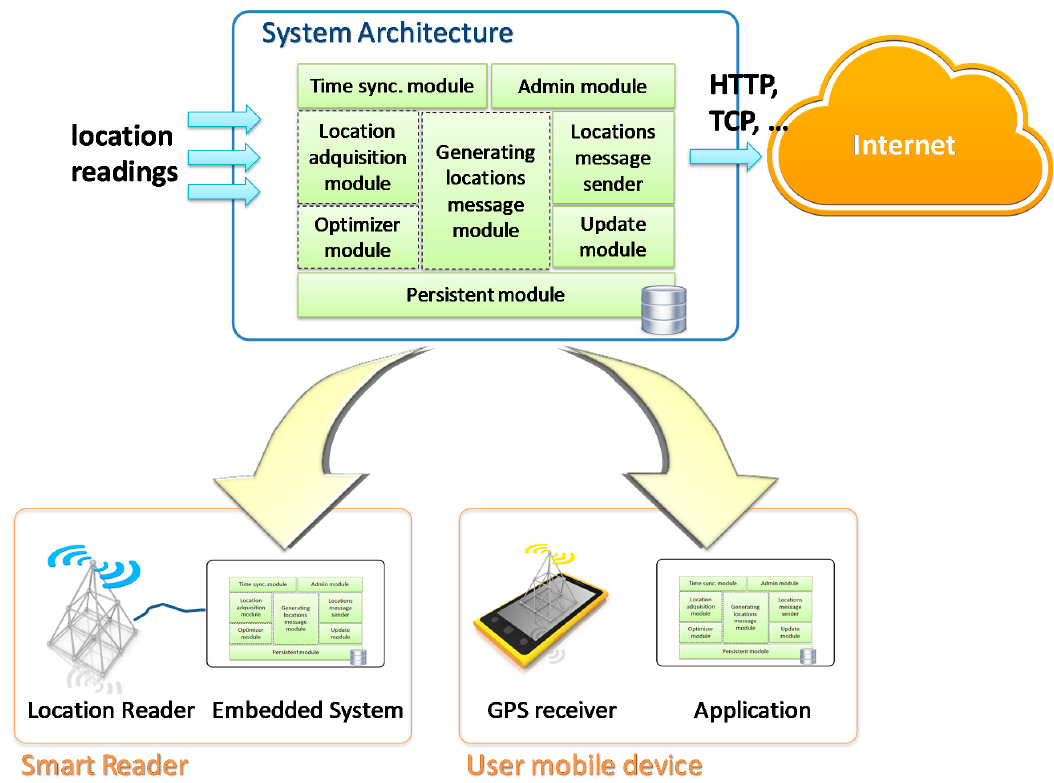
Figure 3. Computational architecture of the acquisition components.